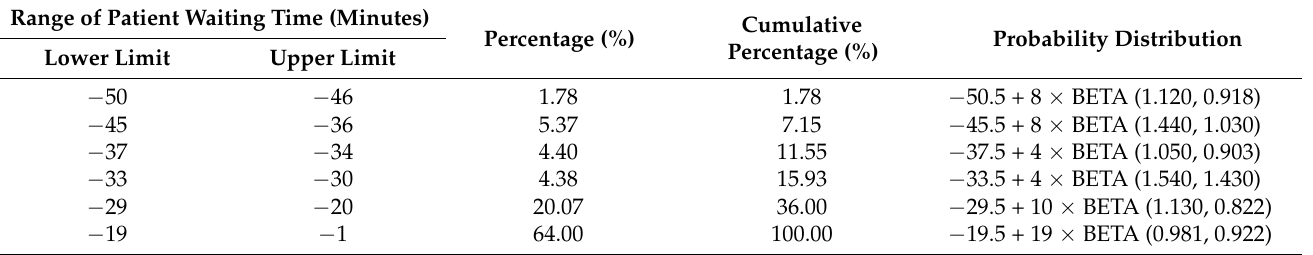
Table 1. F3 distribution for early outpatients.